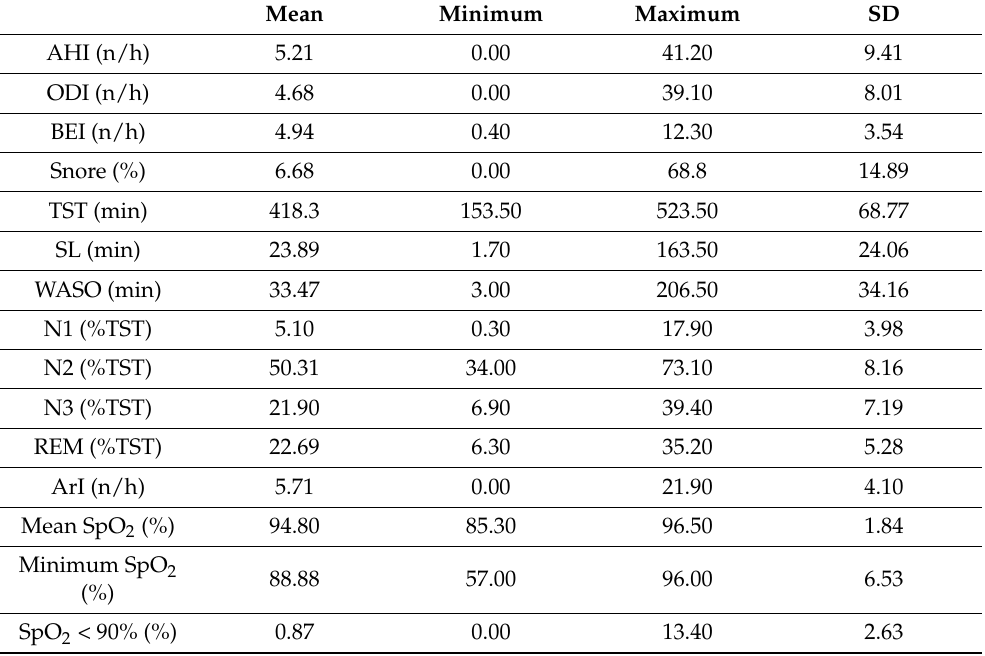
Table 1. Polysomnographic characteristics of the study group ( n =